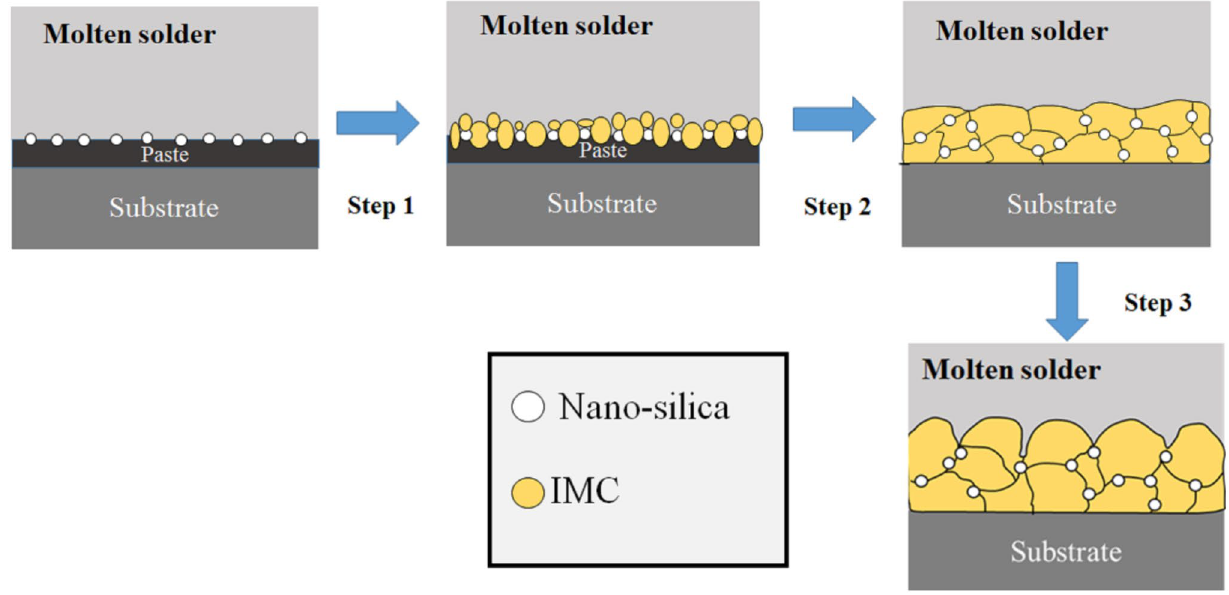
Fig. 8 Schematic diagram of proposed IMC formation for silver paste coated with silica